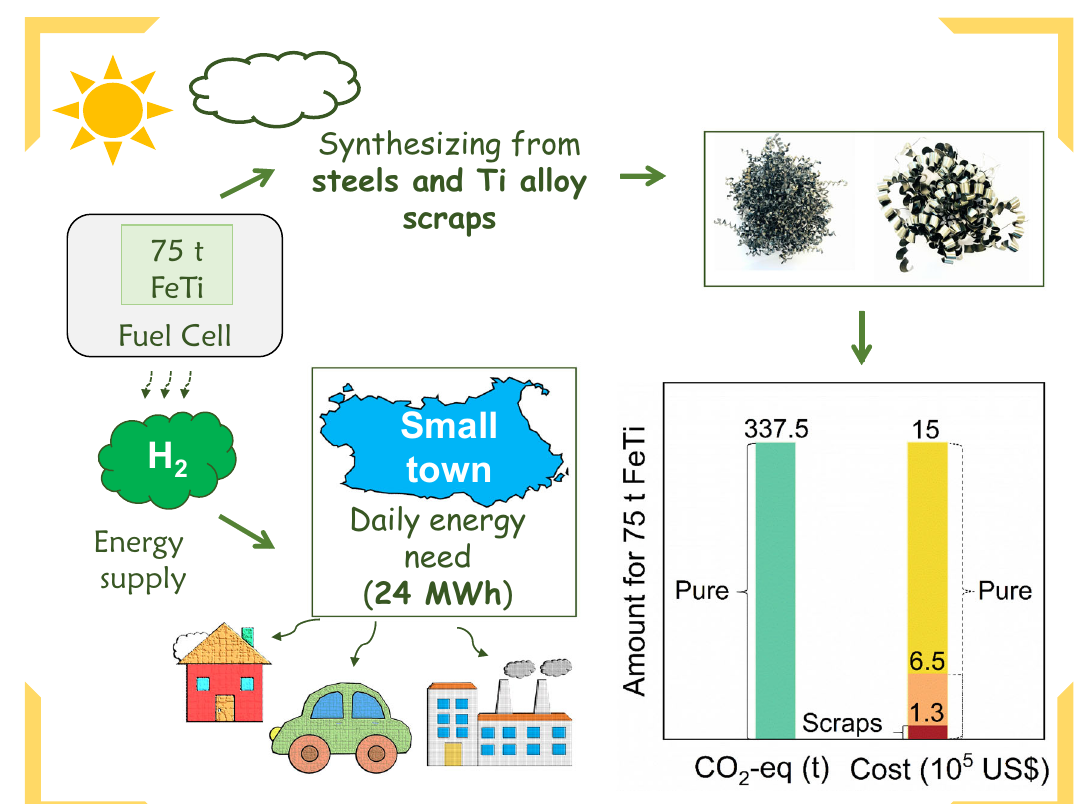
Fig. 7 Schematics for utilizing hydrogen contained in FeTi to store the daily energy needed for a small community. The CO 2 -eq and cost reduction achieved by utilizing FeTi obtained from metal scraps instead of high-purity Fe and Ti is provided in the column